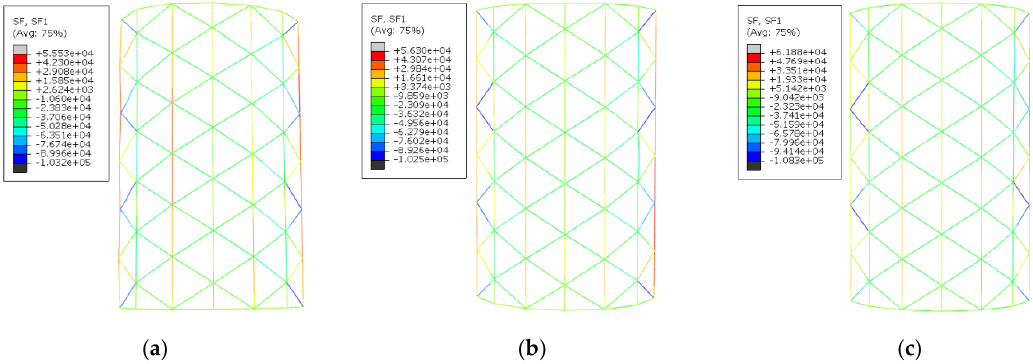
Figure 21. The axial force of the structure in different fire conditions. ( a ) Fire location I (1863s); ( b ) fire location II (582s); ( c ) fire location III (567s).